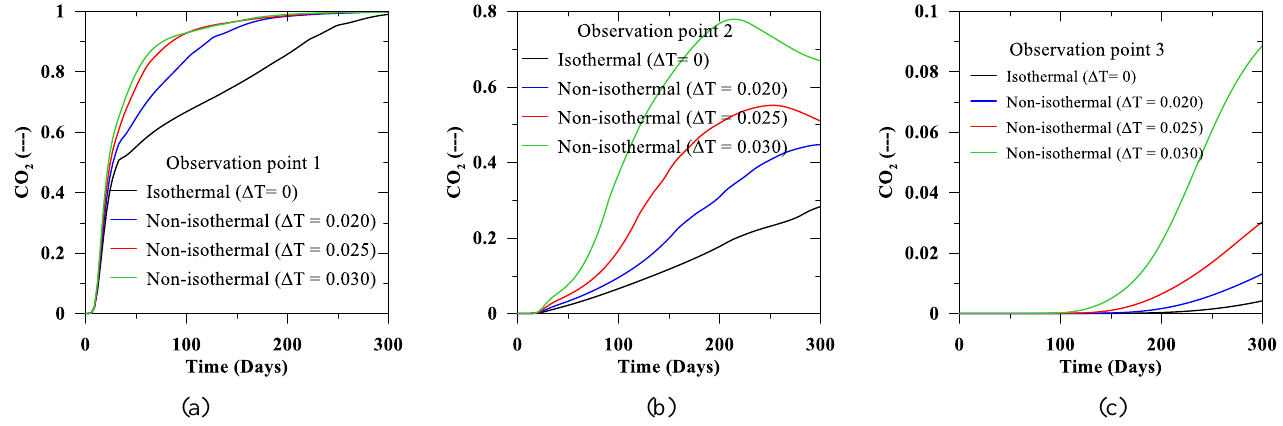
Figure 7. Thermal effect on the distribution of pressure in different observation points ( a – c ).